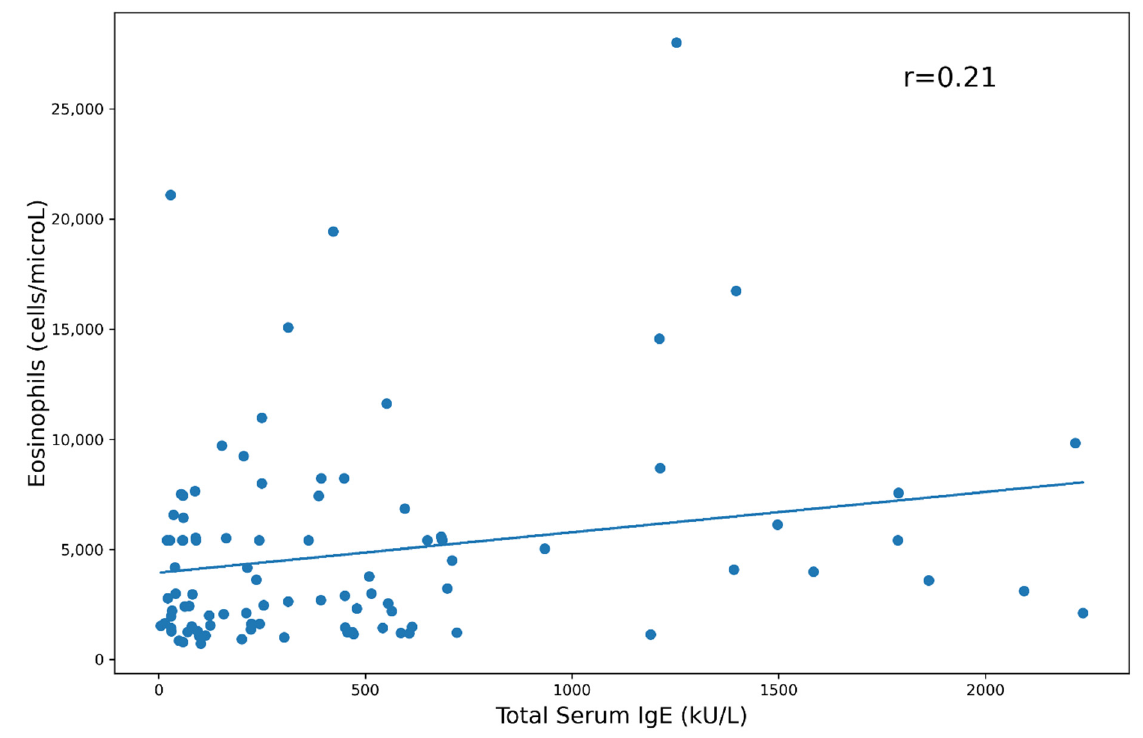
Figure 5. Eosinophils absolute count vs. total IgE.